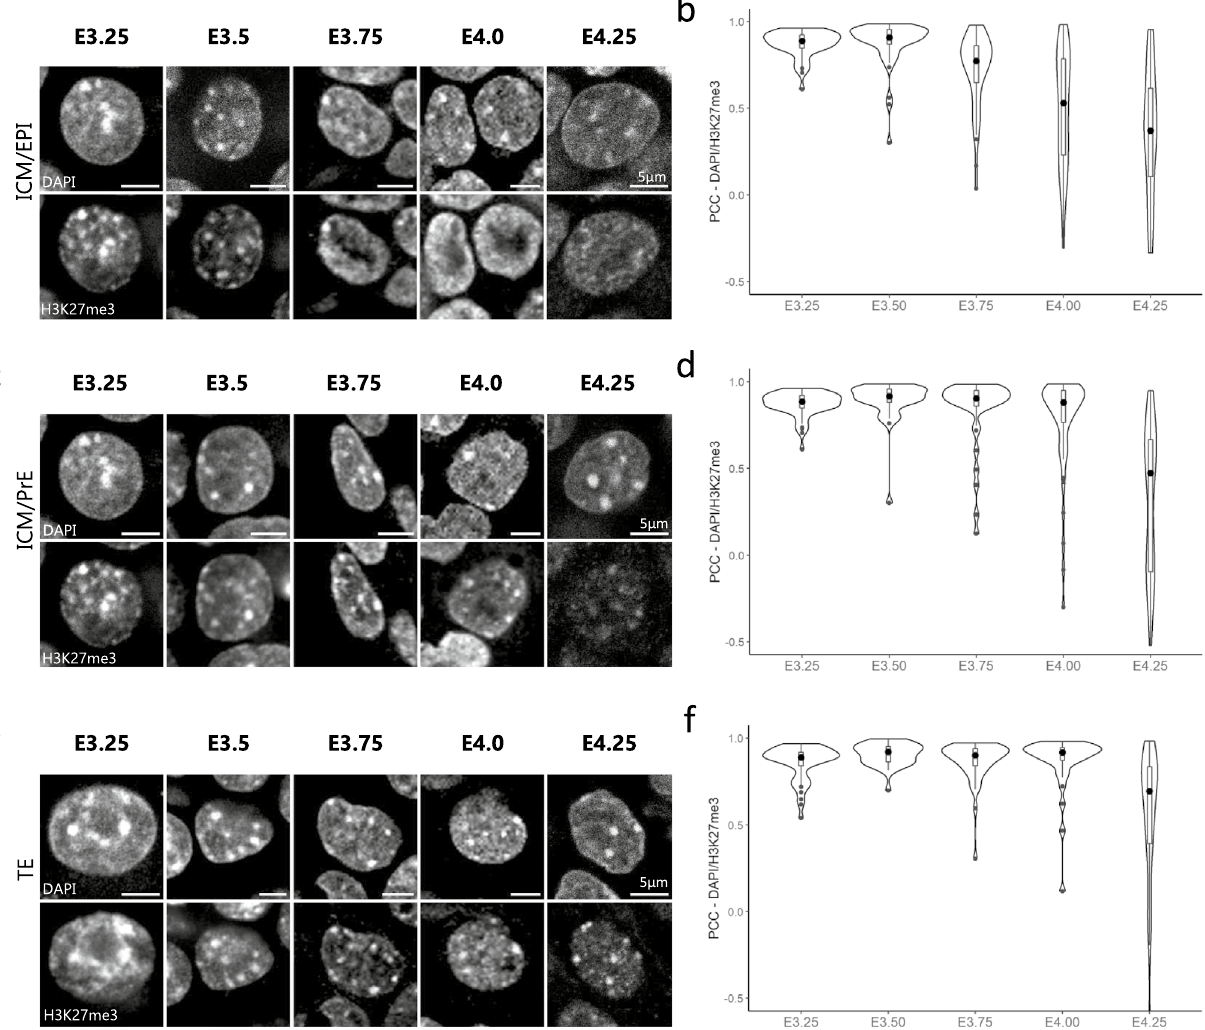
Figure 3. Correlation dynamics between DAPI and H3K27me3 signals at chromocenters at blastocyst stages. (a , c and e ) Pattern of H3K27me3 in a representative nucleus of EPI ( a ), PrE ( c ) and TE ( e ) cells at different blastocyst stages (from E3.25 to E4.25). DNA is stained with DAPI. Scale bar represents 5 µm. ( b , d and f ) Violin plots show the distribution dynamics of the Pearson’s Correlation Coefficients (PCC) between DAPI and H3K27me3 profiles at chromocenters in EPI ( b ), PrE ( d ) and TE ( f ) cells at various stages (262, 223 and 196 chromocenters analysed respectively). Graphs were generated using ggplot2 56 (v3.3.5) in R and figures were arranged with FigureJ 55 in Fiji 54